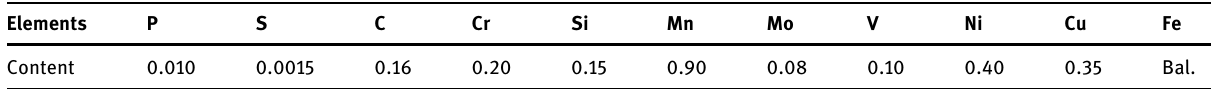
Table 1: Chemical composition of EH40 steel ( wt% )